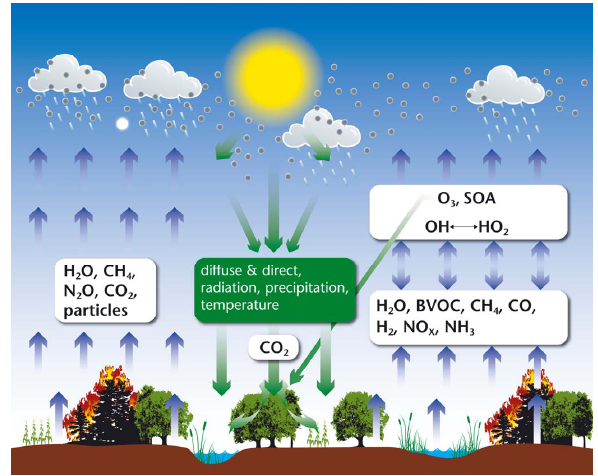
1 Fig. 1. Conceptual overview of terrestrial carbon cycle – chemistry – climate interactions. The land surface affects atmospheric chem- istry and climate directly via surface energy partitioning into latent and sensible heat flux (not shown), and emissions of greenhouse gases (H 2 O, CH 4 , N 2 O, CO 2 ) and aerosol particles from forests, grasslands, wetlands, agricultural systems, and vegetation biomass burning. Atmospheric chemistry and climate is also affected by at- mospheric reactions of reactive trace gases emitted from vegetation, soils and fires (H 2 O, BVOC, CH 4 , CO, NO x , NH 3 , H 2 ) . These con- tribute to complex oxidation patterns along variable pathways that depend on the overall chemical and physical environment. Reaction kinetics vary greatly, and the lifetime of substances or their reac- tion products may vary from seconds (e.g., some BVOC) to years (e.g., CH 4 ) which in turn determines whether associated chemistry- climate effects are regional or continental to global. The chief ox- idising agent is the hydroxyl radical OH, while some BVOC react directly with O 3 . Tropospheric humidity and hence latent heat flux is an important constraint for OH formation. The main climate rel- evance of the atmospheric reactions is to consume or generate O 3 , formation of secondary organic aerosol (SOA), and effects on the lifetime of CH 4 . Climate feedbacks in the system occur directly (e.g., via the temperature and/or light response of emissions) or in- directly via climate or, for example, O 3 effects on vegetation com- position, productivity and carbon